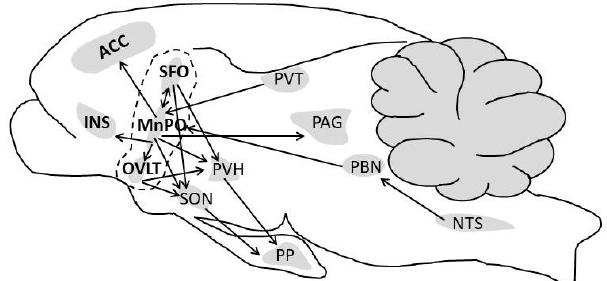
Figure 5. Rodent brain loci that have been associated (2016–2019) with dehydration-induced drinking [82,90–92,94,113,151]. In this idealistic illustration, arrows denote evidence-based neural circuits that integrate intracellular or extracellular signals and modulate thirst, drinking, rapid satiety, overdrinking, and aversive motivational drives. Abbreviations: IC, insular cortex (insula); SFO, subfornical organ; PVT, paraventricular thalamic nucleus; PP, posterior pituitary; additional brain loci are defined in the text and Table 2 footnote.